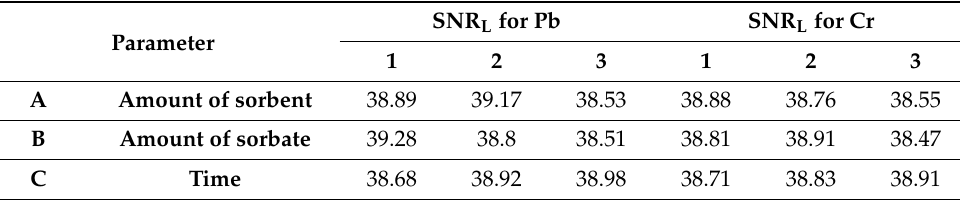
Table 3. Level mean SNR (SNR L ) for different parameters levels for Pb and